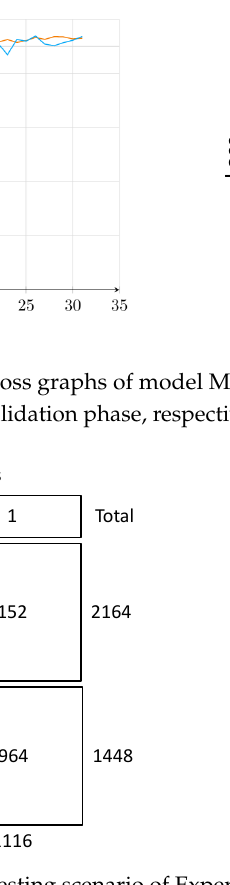
Figure 5. Confusion matrix testing scenario of Experiment